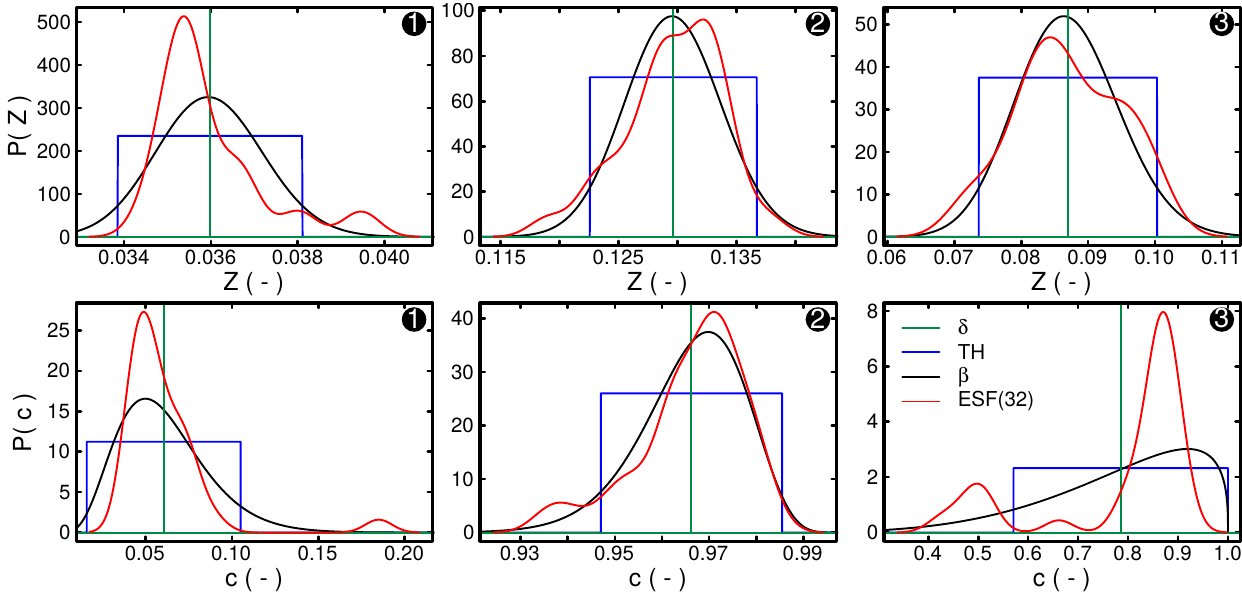
Figure 9. Comparison of common presumed subgrid PDF shapes and kernel density estimation (KDE) approximation of the PDF obtained from the ESF simulation with 32 stochastic fields at the various time instants displayed in Figure 8 at the probe position A shown in Figure